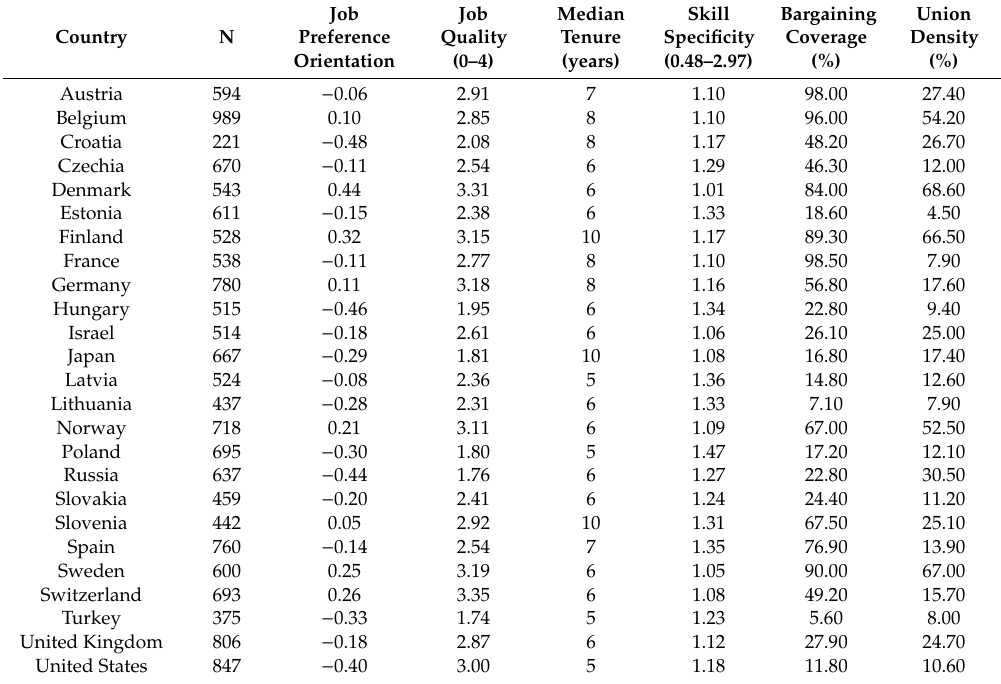
Table A3. Country